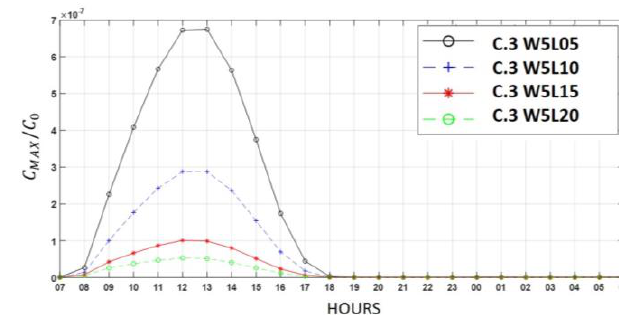
Fig. 7. Daily variation of the nondimensional maximum CO concentration C MAX /C 0 inside the courtyard 3, for the different simulated courtyard dimensions.